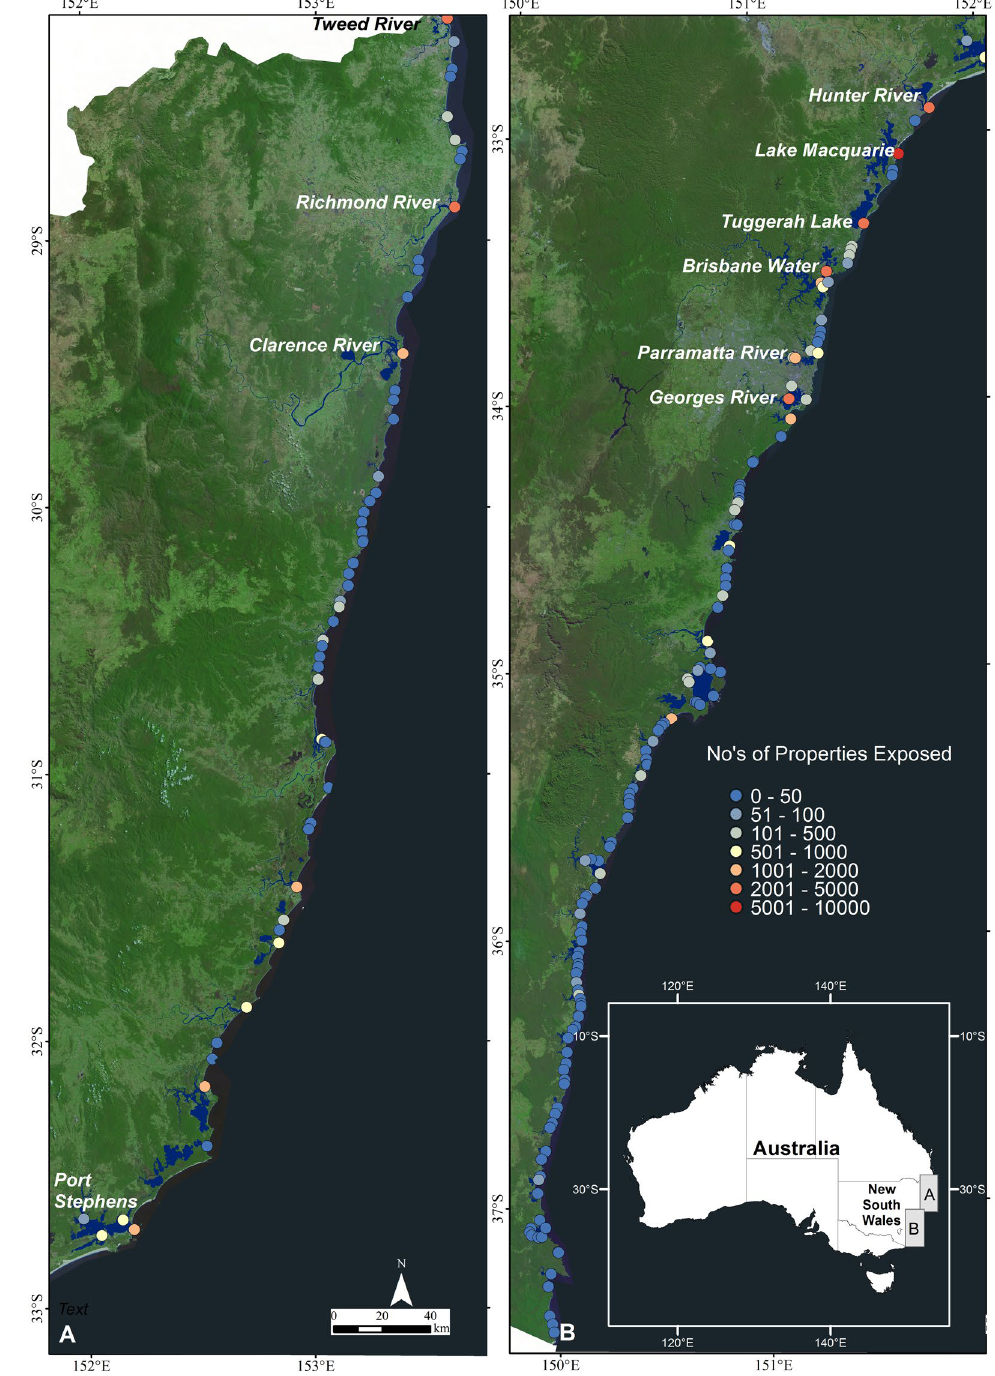
Figure 5. Geographical spread of exposure for the 1 m sea level rise scenario and locations of the 10 most exposed estuaries. This figure was created using ARCGIS v10.4